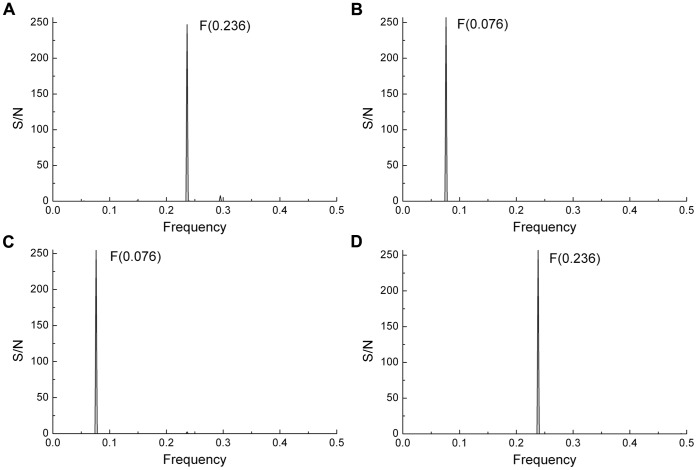
Comparison of informational spectra of seasonal H1N1 and Egyptian H5N1-HPAIV.(a) Cross-spectrum of HA1 of representative seasonal H1N1 viruses (n = 1576). (b) Cross-spectrum of all currently available Egyptian H5N1-HPAIV (n = 526). (c) Cross-spectrum of Egyptian H5N1-HPAIV isolated between 2006–2008 and (d) 2009–2011.